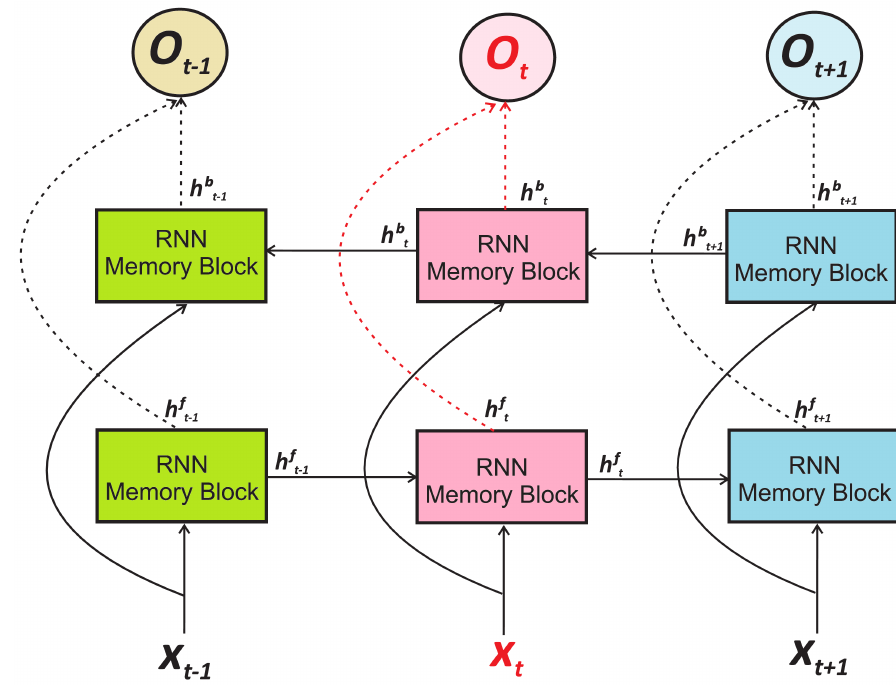
Figure 3. Typical Structure of Bidirectional Recurrent Neural Network shown at step three.